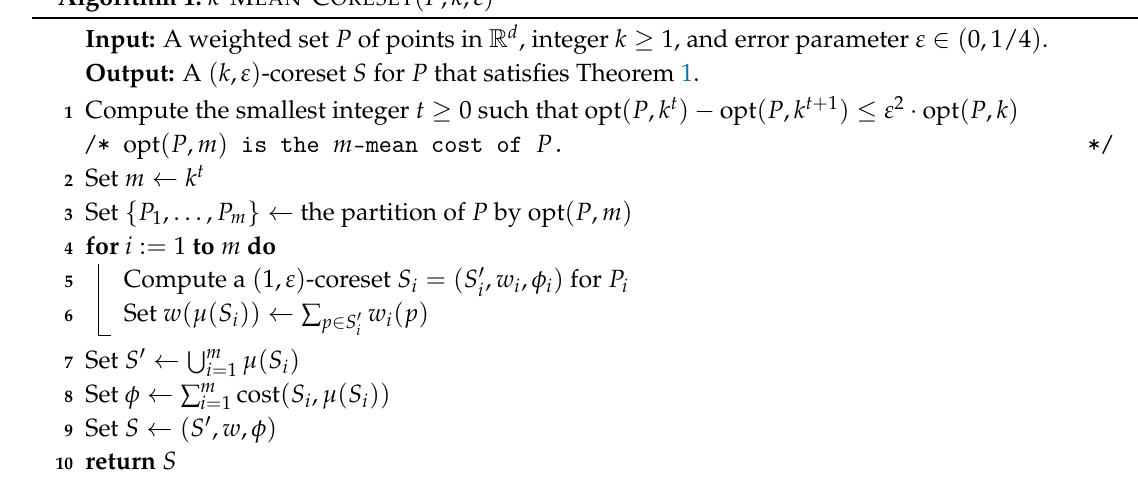
Algorithm 1: k -M EAN -C ORESET ( P , k , ε